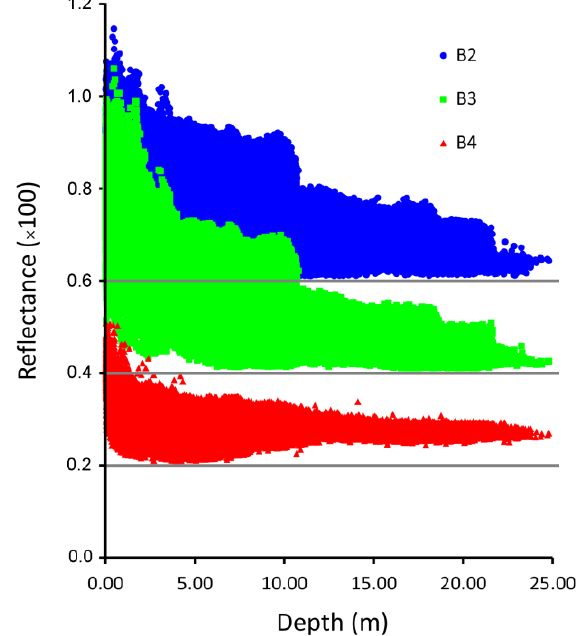
Figure 3. Scaled reflectance values of blue, green, and red bands versus depth values in all pixels of the satellite image of the study